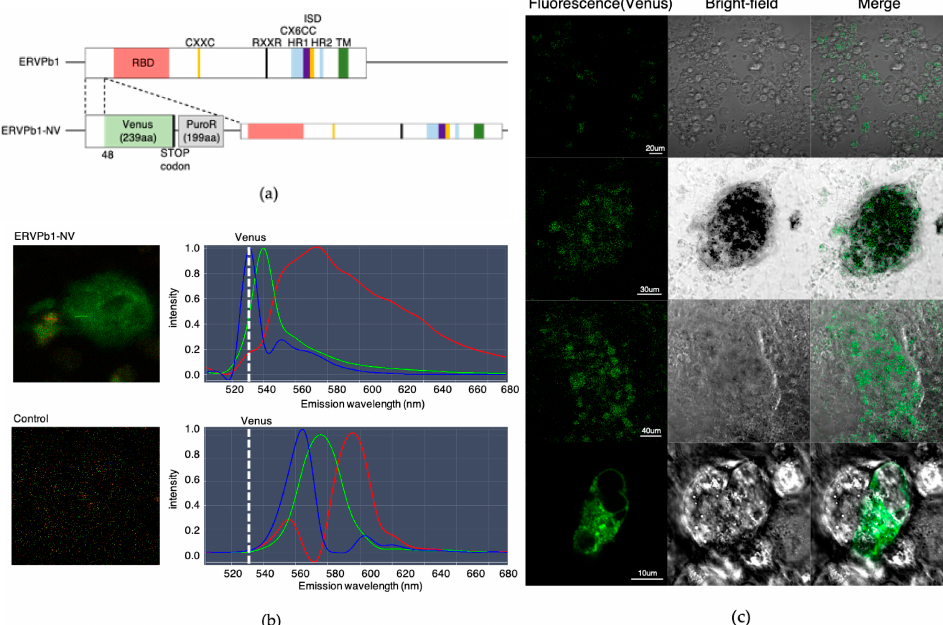
Figure 2. ERVPb1–Venus fusion protein detected under a condition of iPSC differentiation in the three germinal layers. ( a ) Structure of the ERVPb1-NV knock-in construct. The Venus gene was introduced into endogenous ERVPb1 so that the Venus protein was fused with ERVPb1 just after the 48 amino acids of its N-terminus (ERVPb1–Venus fusion protein). Most of the ENV features of this putative protein were removed in this construct except for the N-terminal signal peptide sequence. ( b ) Peak separation between the Venus-fusion protein (maximum peak emission fluorescence wavelength: 528 nm) and autofluorescence in human iPS cells with or without Venus insertion. The white dotted line indicates the wavelength of Venus. The ERVPb1–Venus fusion protein was detected only in the ERVPb1-NV iPSCs, not in the control iPSCs. ( c ) Fluorescence (Venus), Bright-field, and the merged images of ERVPb1-NV iPSCs differentiated into the three germ layers.